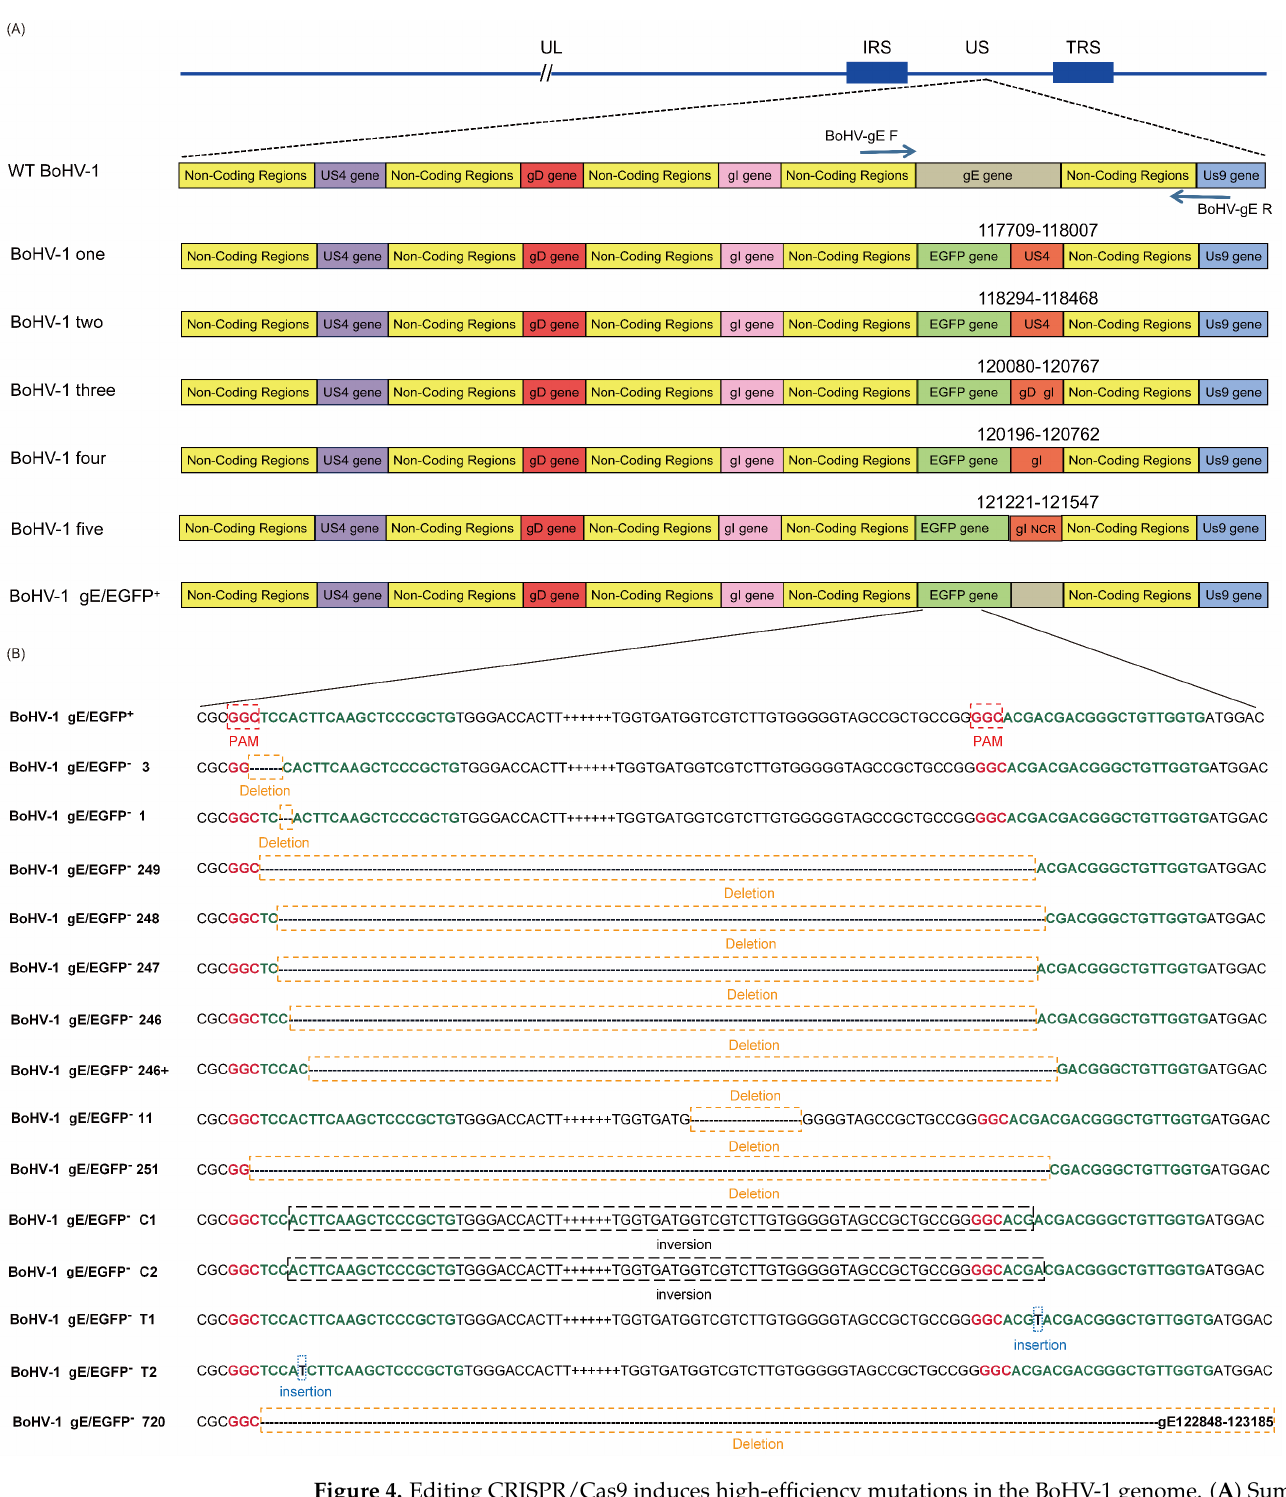
Figure 4. Editing CRISPR/Cas9 induces high-efficiency mutations in the BoHV-1 genome. ( A ) Sum- mary of representative mutations of BoHV-1 induced with px459-EGFP-sgRNA1 and px459-EGFP- sgRNA2 appearing outside the EGFP sequence. ( B ) Summary of representative mutations of BoHV-1 induced with px459-EGFP-sgRNA1 and px459-EGFP-sgRNA2 appearing inside the EGFP se- quence.